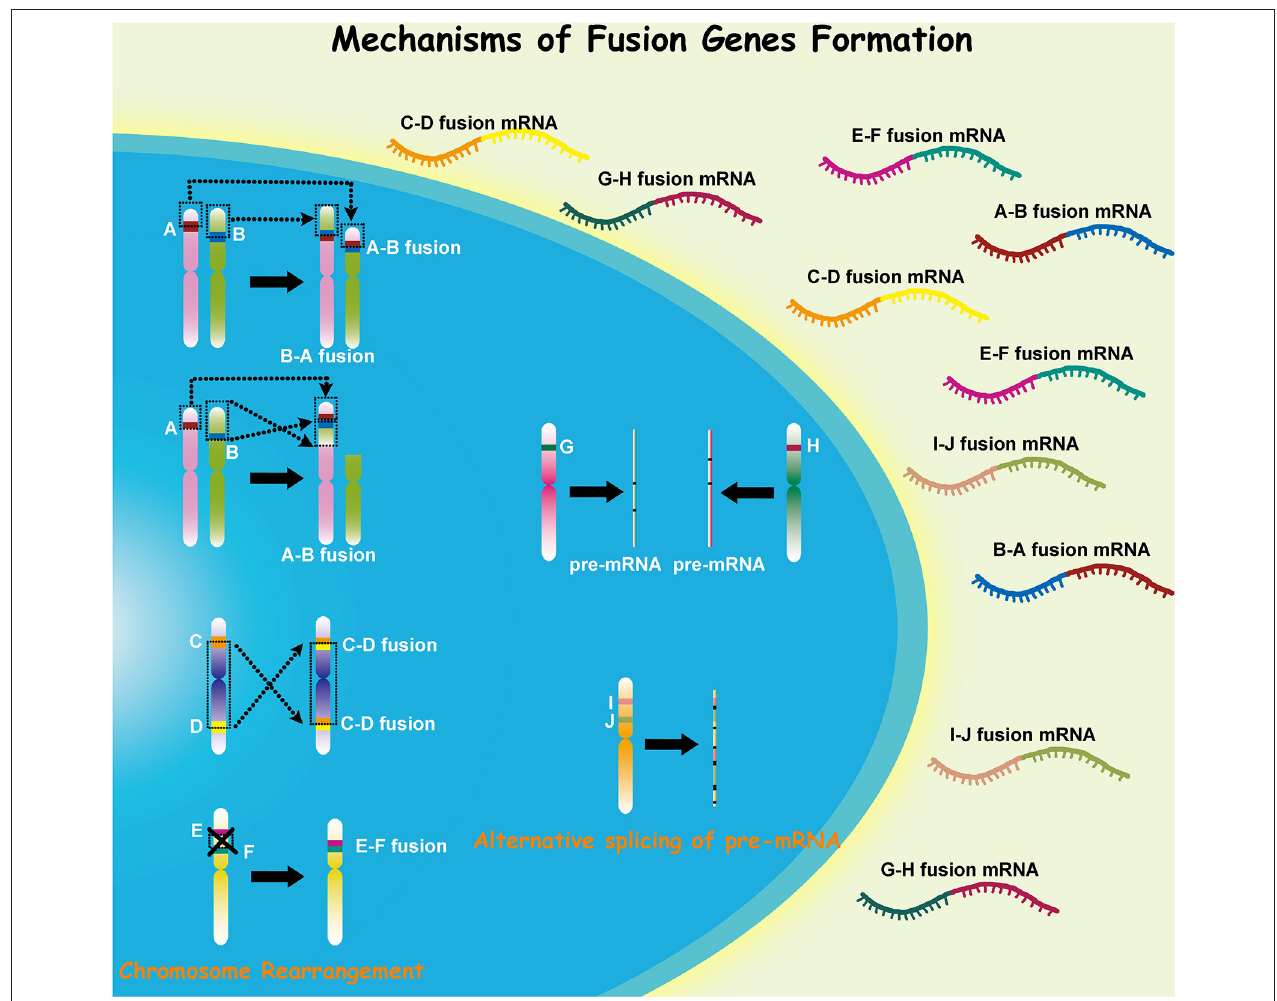
FIGURE 1 | Different mechanisms in the formation of fusion